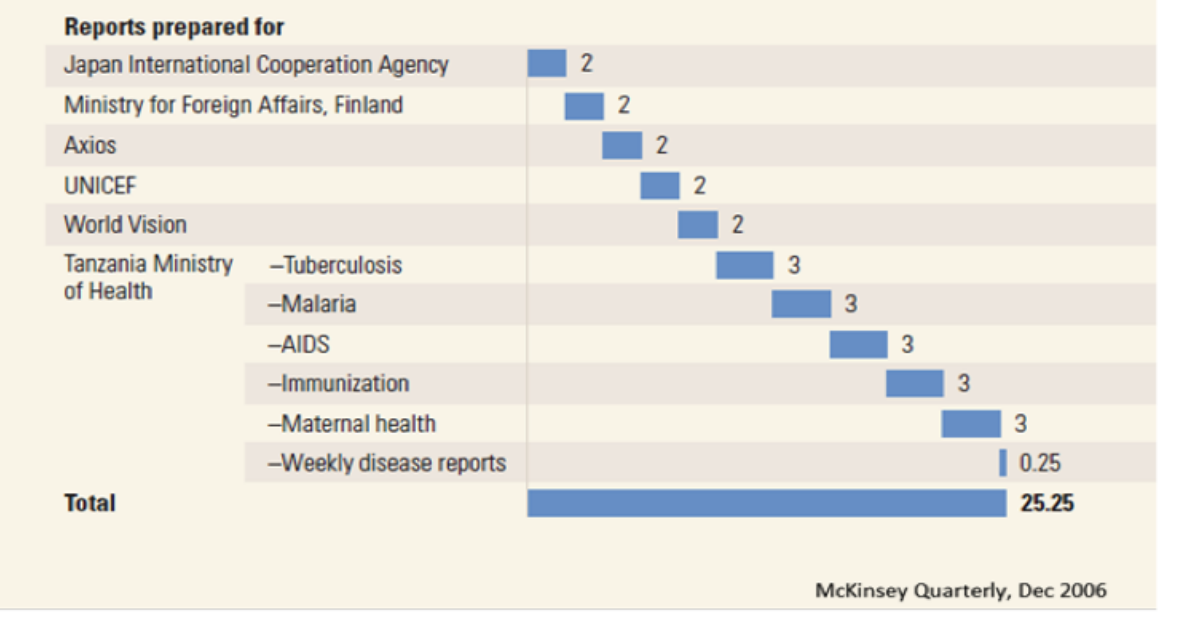
Figure 1. Number of full days per quarter spent writing reports by district medical officer (Morogoro,